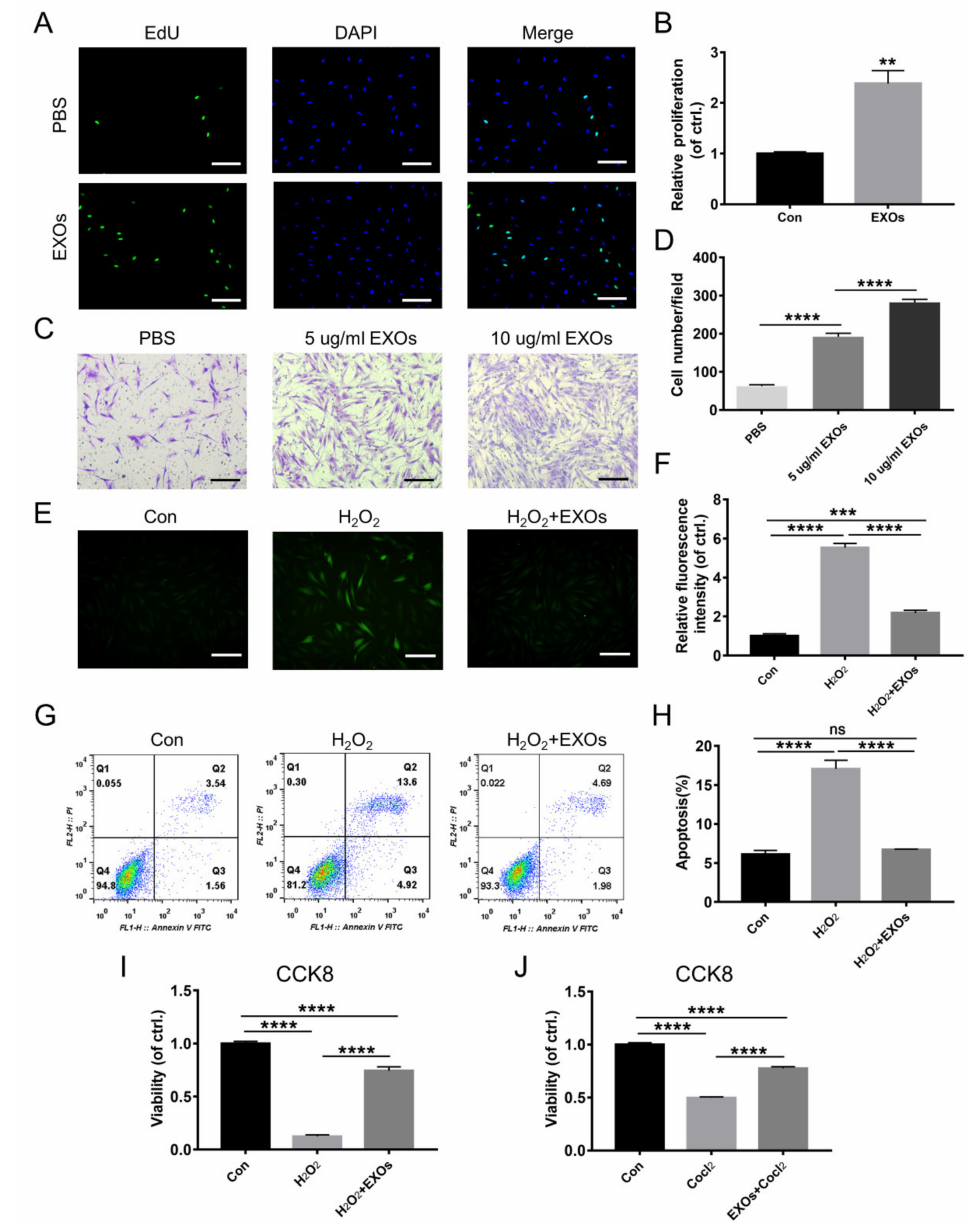
Figure 1. ADSC-EXOs promoted fibroblasts proliferation and migration and attenuated intracellular ROS levels and cell damages caused by hypoxia and oxidative stress. ( A ) Representative fluores- cent images of proliferative fibroblasts after ADSC-EXOs treatment. ( B ) Quantitative analysis of the data in ( A ). ( C ) Representative images of migratory fibroblasts given ADSC-EXOs treatments. ( D ) Quantitative analysis of the data in ( C ). Fibroblasts were pre-treated with ADSC-EXOs or PBS for 24 h, then exposed under H 2 O 2 for 6 h or CoCl 2 for 24 h, and finally assessed by the following assays. ( E ) Representative images of DCFH fluorescence in fibroblasts given the above treatments. ( F ) Quantitative analysis of the relative DCFH fluorescence intensity. ( G ) Flow cytometry analysis of the cell apoptosis in each group. ( H ) Quantitative analysis of the apoptosis rate. ( I ) Quantitative analysis of the cell viability of fibroblasts under H 2 O 2 exposure by CCK8 assay. ( J ) Quantitative analysis of the cell viability of fibroblasts under CoCl 2 exposure by CCK8 assay. Scale bar: 100 µ m. n = 3. ** p < 0.01, *** p < 0.001, **** p <